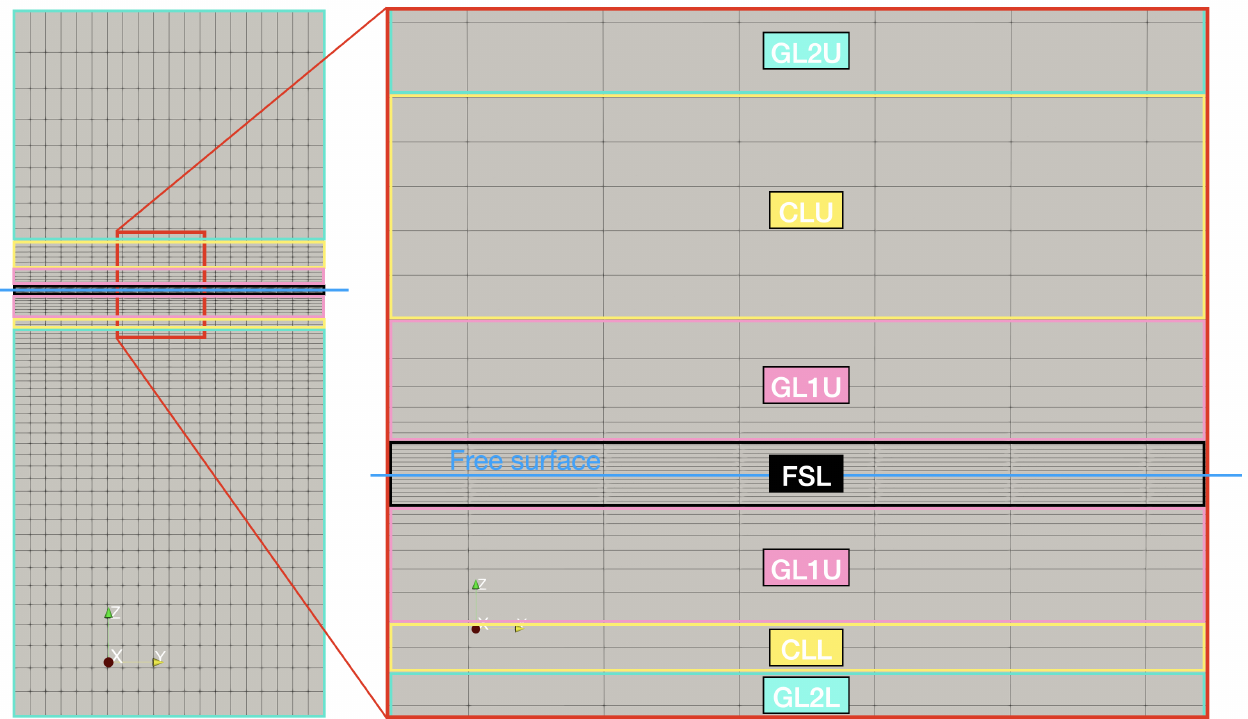
Figure 7. Generated mesh of the inlet